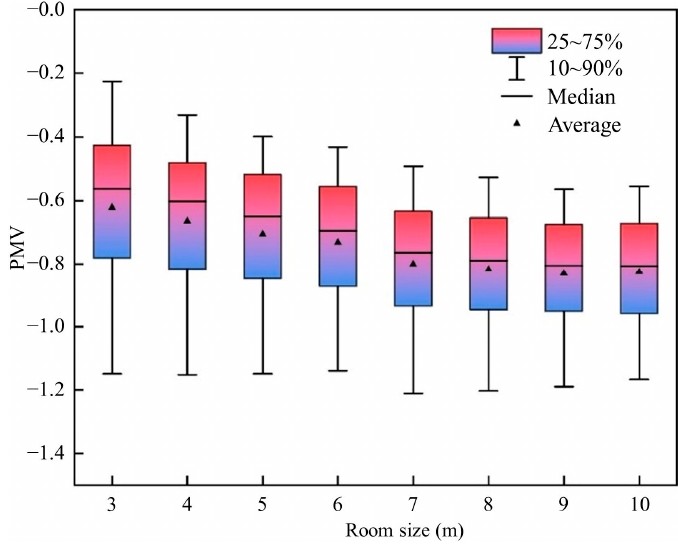
Figure 12. PMV distribution in rooms with different widths.